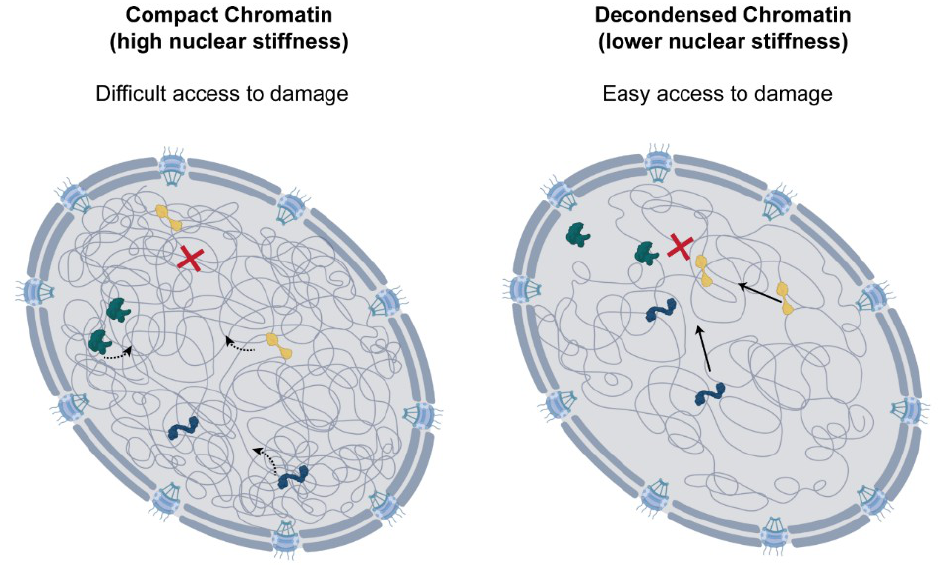
Figure 3. Role of chromatin decondensation following DNA damage. Chromatin decondensation leads to higher nuclear diffusion, which could be important for rapid access of repair factors to DNA lesions. This could support the efficient repair of DNA damage.